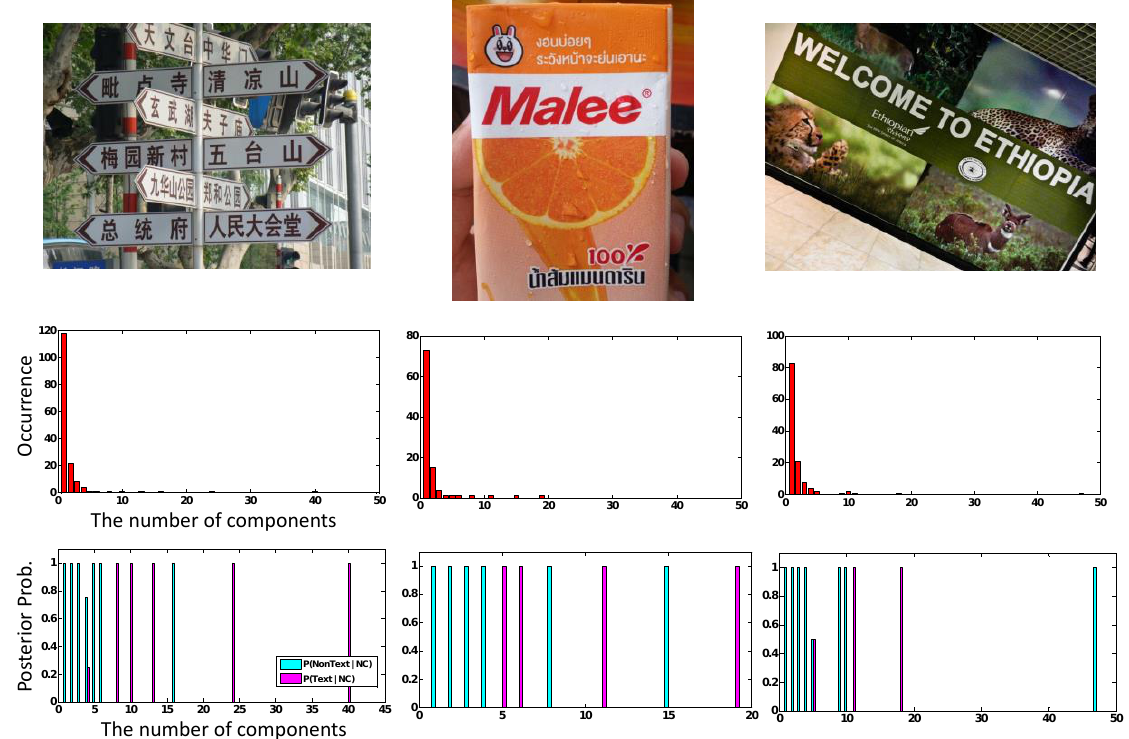
Figure 5. Histograms of the number of components and posterior